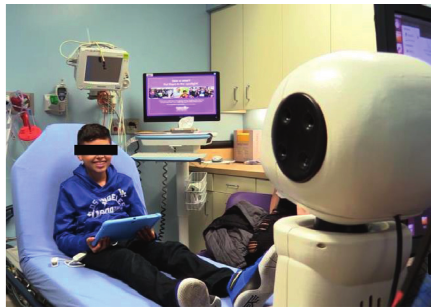
Figure 2: Interaction environment and setup. Patient preparing to interact with IVEY who is situated at the end of the hospital